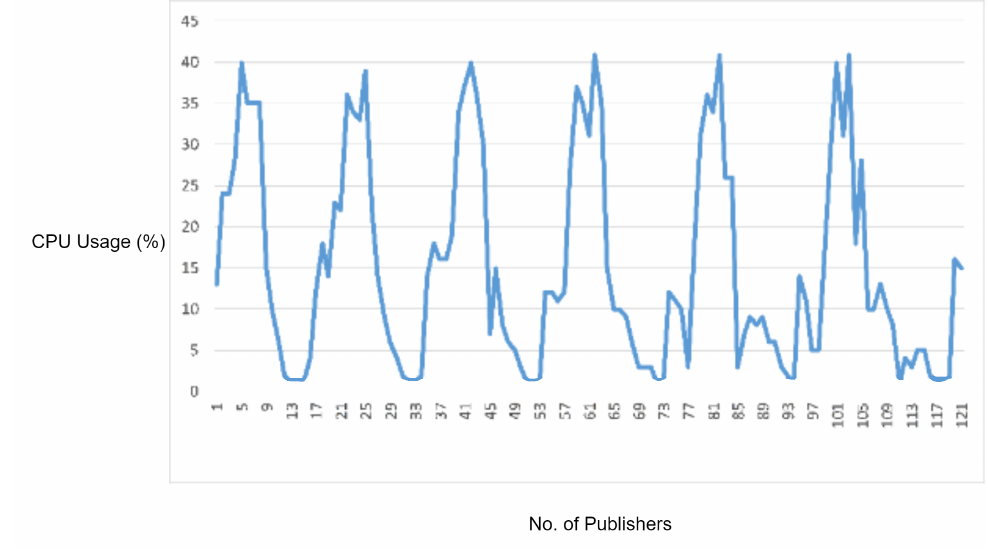
Figure 9. CPU usage captured while testing the normal use case.